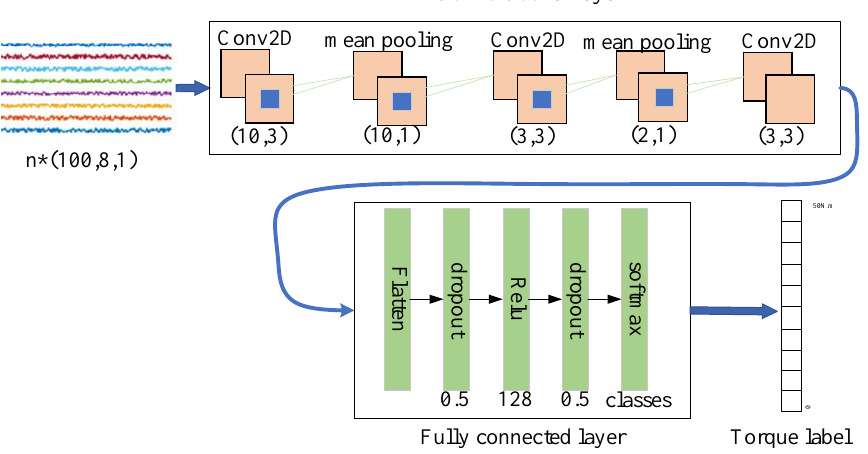
Figure 2. Framework of independent CNN.